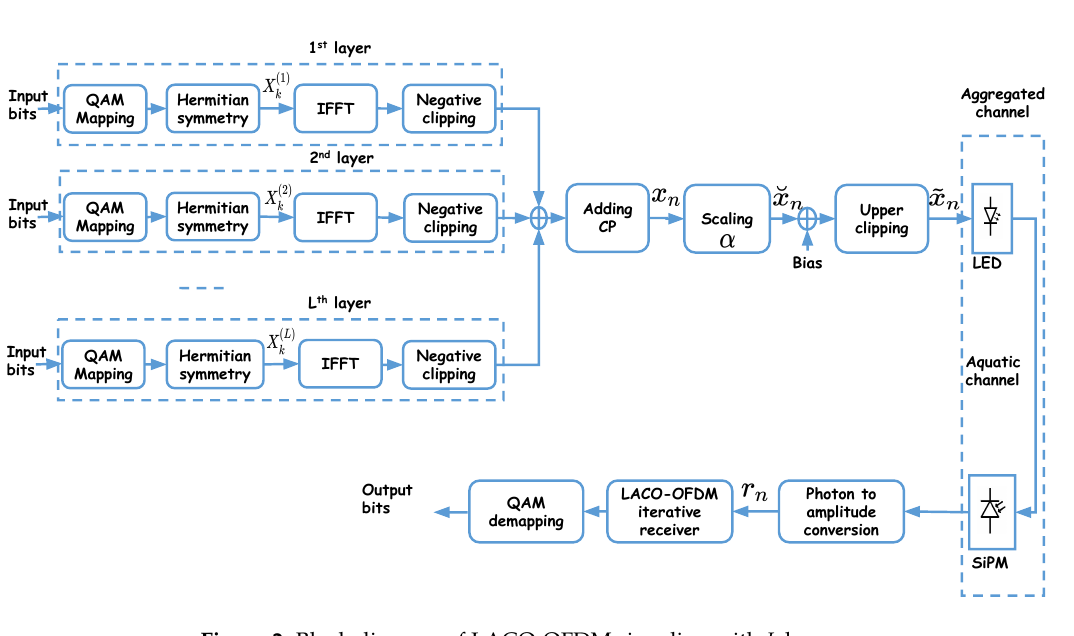
Figure 2. Block diagram of LACO-OFDM signaling with L